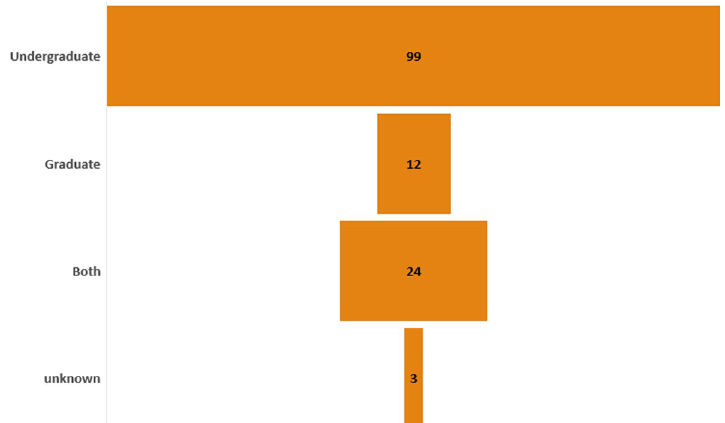
Fig. 5 Academic level distribution by number of articles